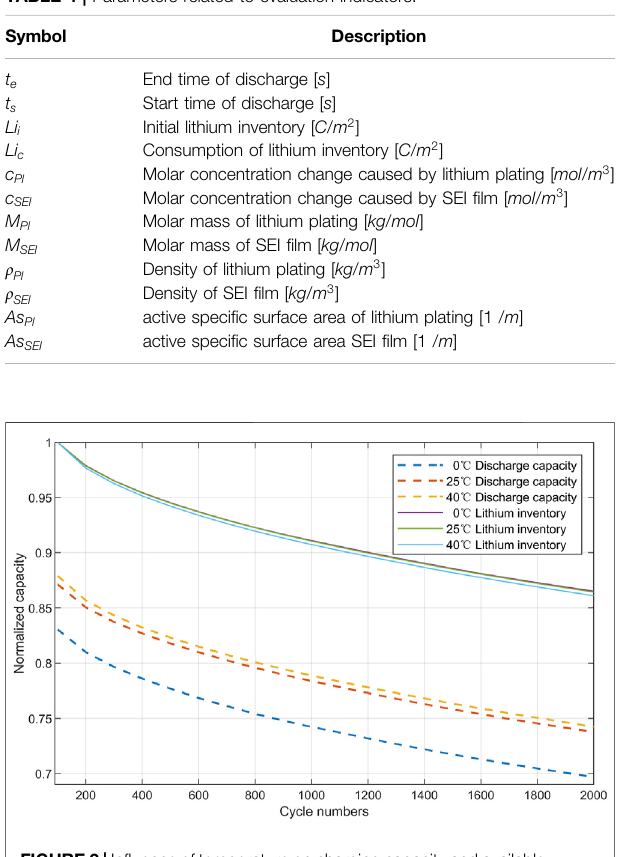
FIGURE 2 | In fl uence of temperature on charging capacity and available lithium-ion decrease.